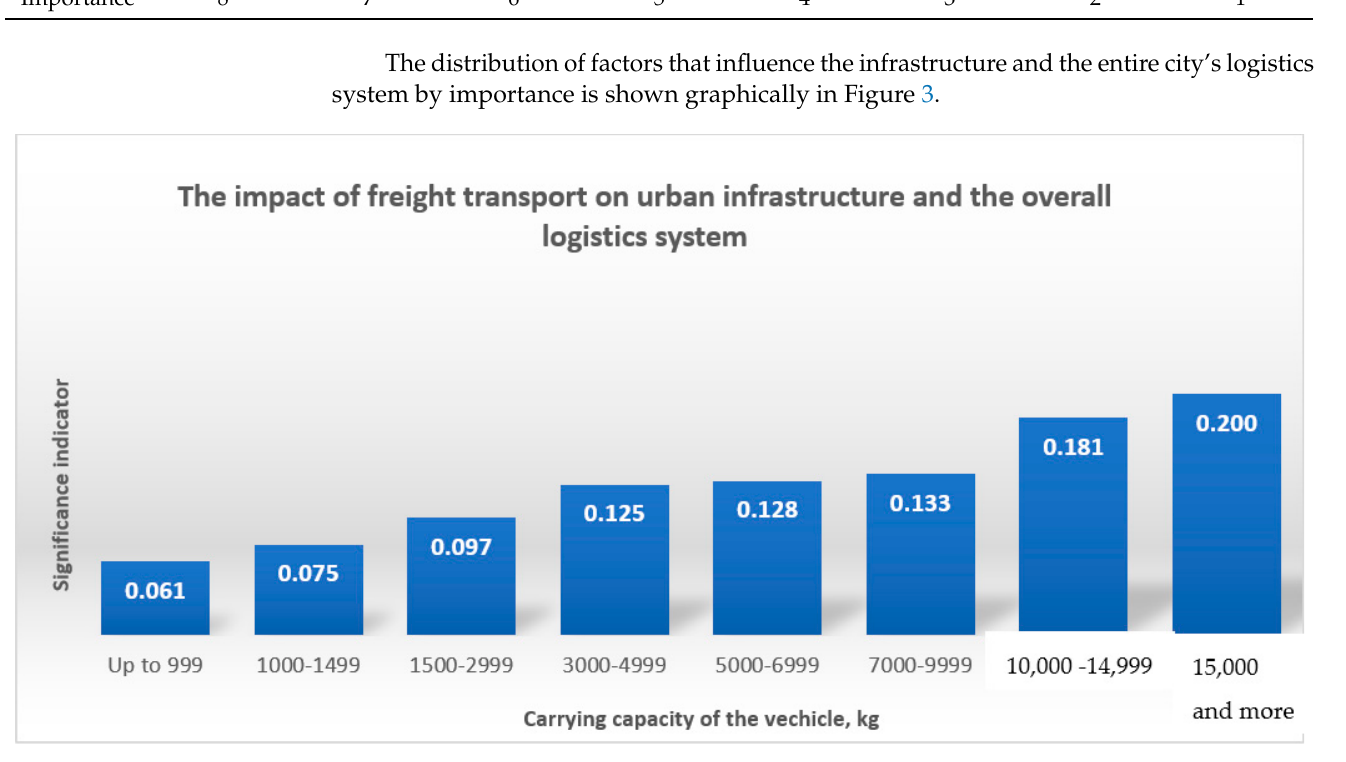
Figure 3. The impact of road vehicles on the infrastructure and the whole logistics system of a city